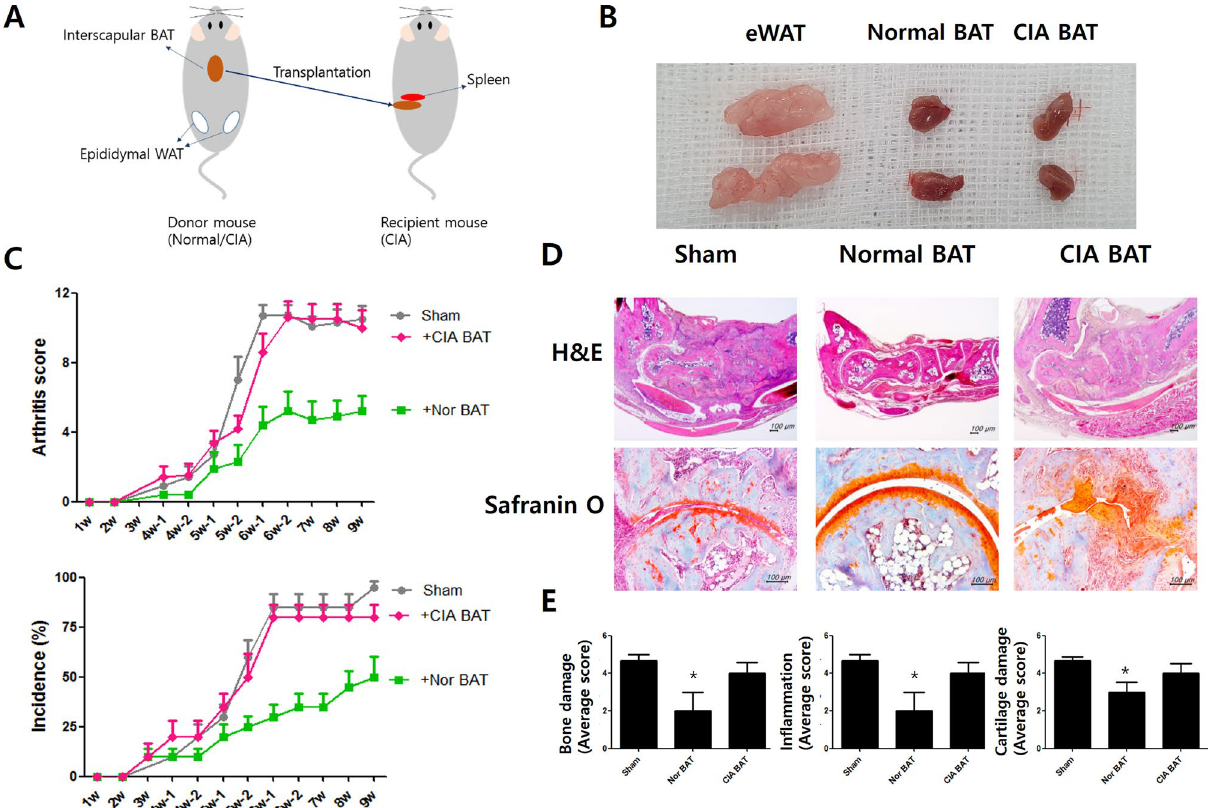
Figure 1. Transplantation of normal brown adipose tissue reduces tissue damage, inflammation, and development of experimental rheumatoid arthritis. ( A ) Schematic representation of the experiments. ( B ) Epididymal white adipose tissues (eWAT), normal brown adipose tissues (normal BAT) and collagen-induced arthritis mice-derived BAT (CIA BAT) were presented. ( C ) Reductions of arthritis score and arthritis incidence were observed in normal BAT-transplanted CIA mice. ( D ) Histological features of the joints were stained with hematoxylin/eosin and Safranin O. ( E ) The histological score of bone damage, inflammation and cartilage damage were presented. *P < 0.05. Scale bars = 100